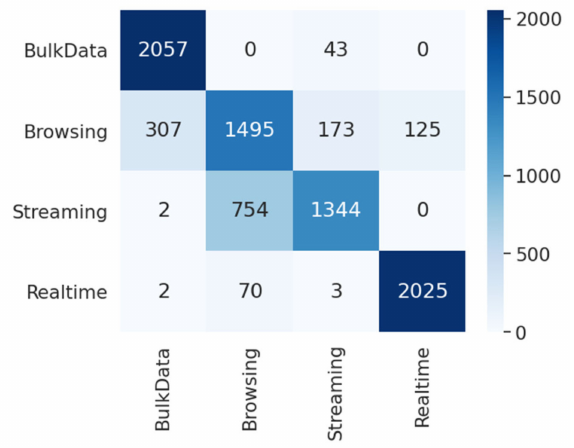
Figure 21. Confusion matrix of P-MLP test.